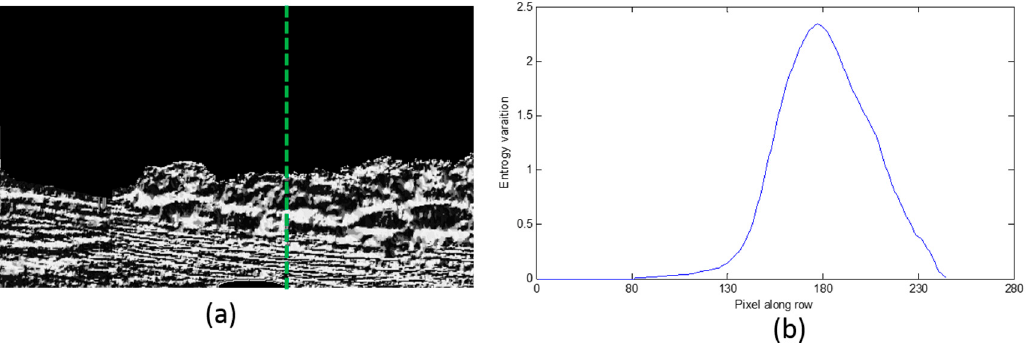
Figure 9. The entropy differential curve when three areas exist. ( a ) The LBP image where the calculation position is shown with the green dashed line; ( b ) The entropy differential curve.